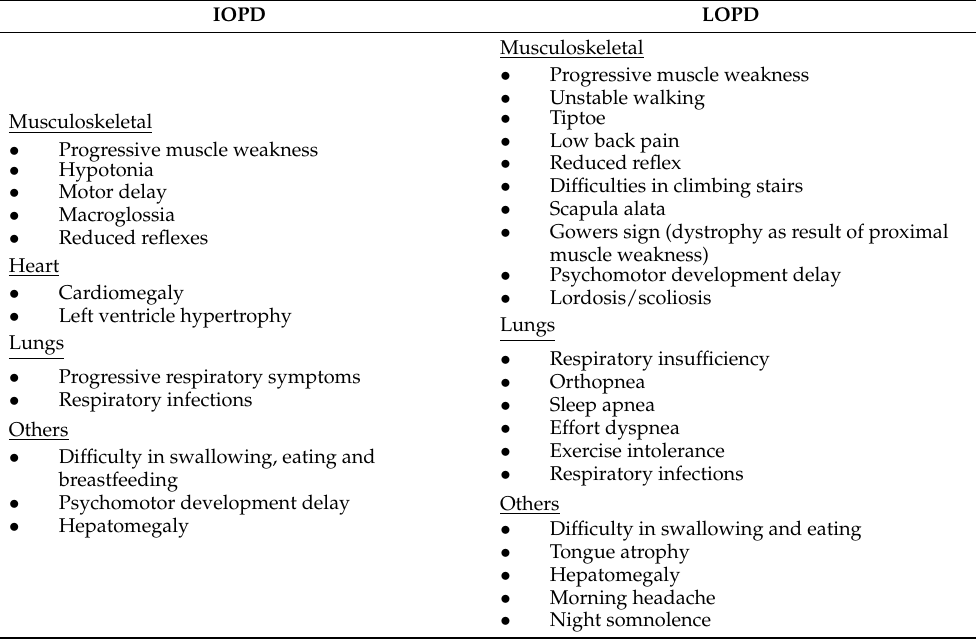
Table 1. Common clinical presentations of